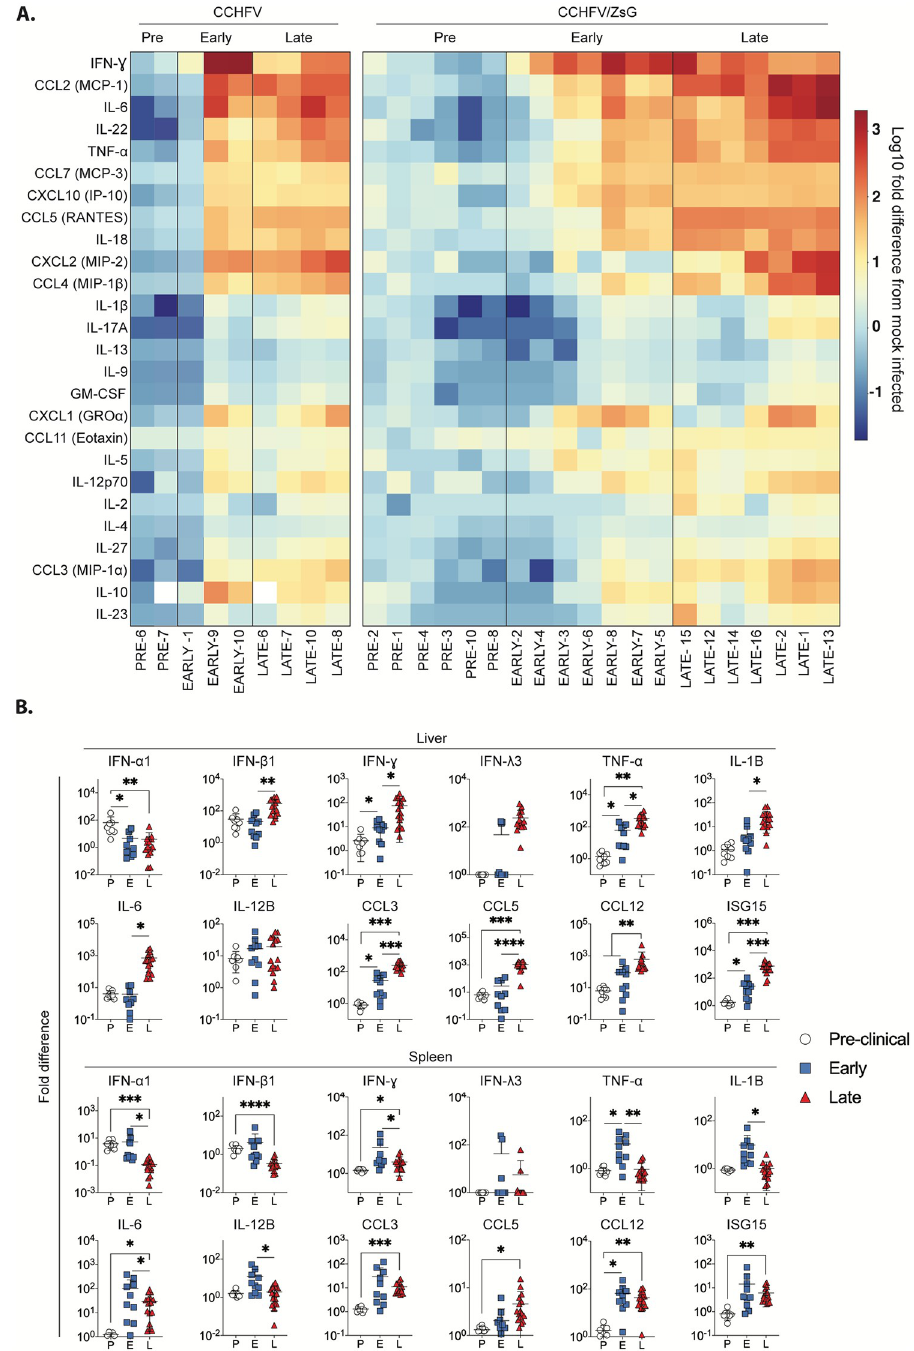
Fig 6. Differential cytokine expression in mice infected with either wild-type CCHFV or CCHFV/ZsG. (A) Cytokine and chemokine heatmap profiles represents the log 10 fold differences in individual plasma cytokine levels or animals classified as being in either the pre-clinical (pre, n = 8), early ( n = 10), or late ( n = 11) stage of infection relative to those detected in control, mock-infected ( n = 6) animals. Cytokine names are shown on the left, and individual animal designations on the bottom. CCL2, monocyte chemotactic protein 1 (MIP-1); CCL3, macrophage inflammatory protein 1 α (MIP-1 α ); CCL4, macrophage inflammatory protein 1 β (MIP-1 β ); CCL5, regulated upon activation, normal T-cell expressed, and secreted (RANTES); CCL7, monocyte chemotactic protein 3 (MIP-3); CCL11, eosinophil chemotactic protein (eotaxin); CXCL1, chemokine (C-X-C motif) ligand-1 like; CXCL2, chemokine (C-X-C motif) ligand-2 like; macrophage inflammatory protein 2 (MIP-2); interferon- γ –induced protein 10